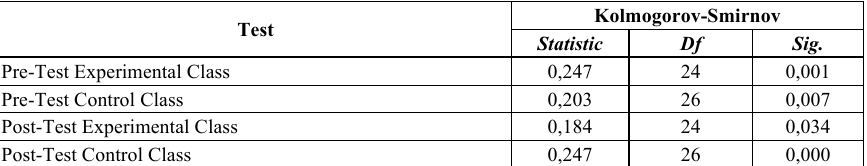
Table 8. Normality Testing